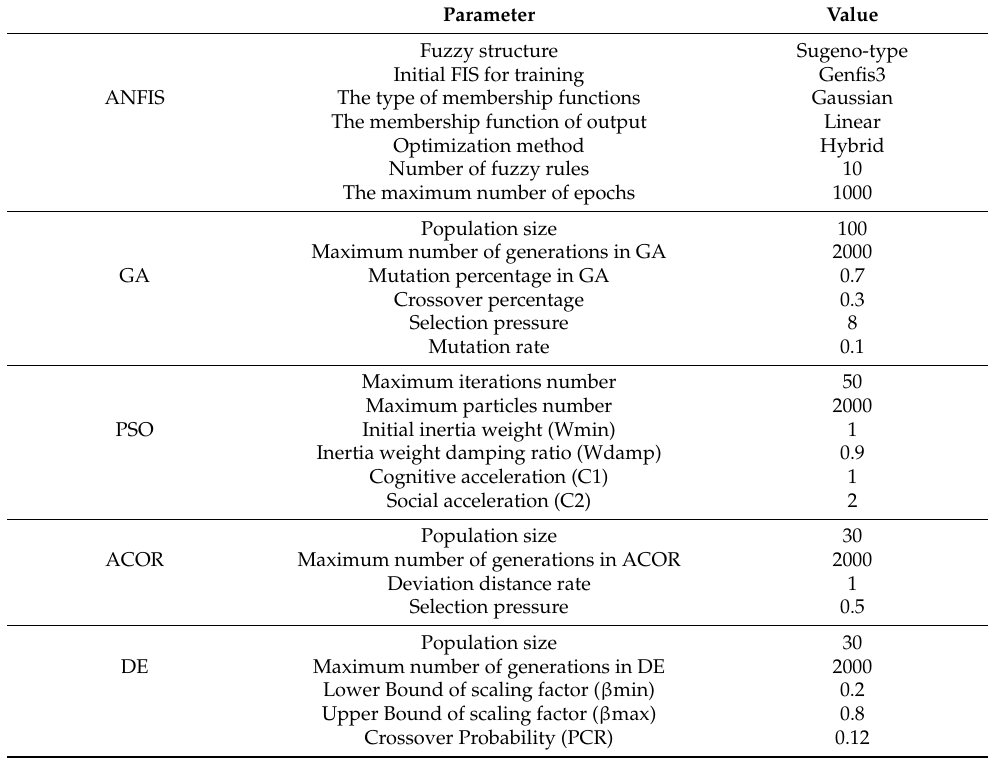
Table 5. Used parameters of the ANFIS and ANFIS-metaheuristic algorithms hybrid models for the prediction of